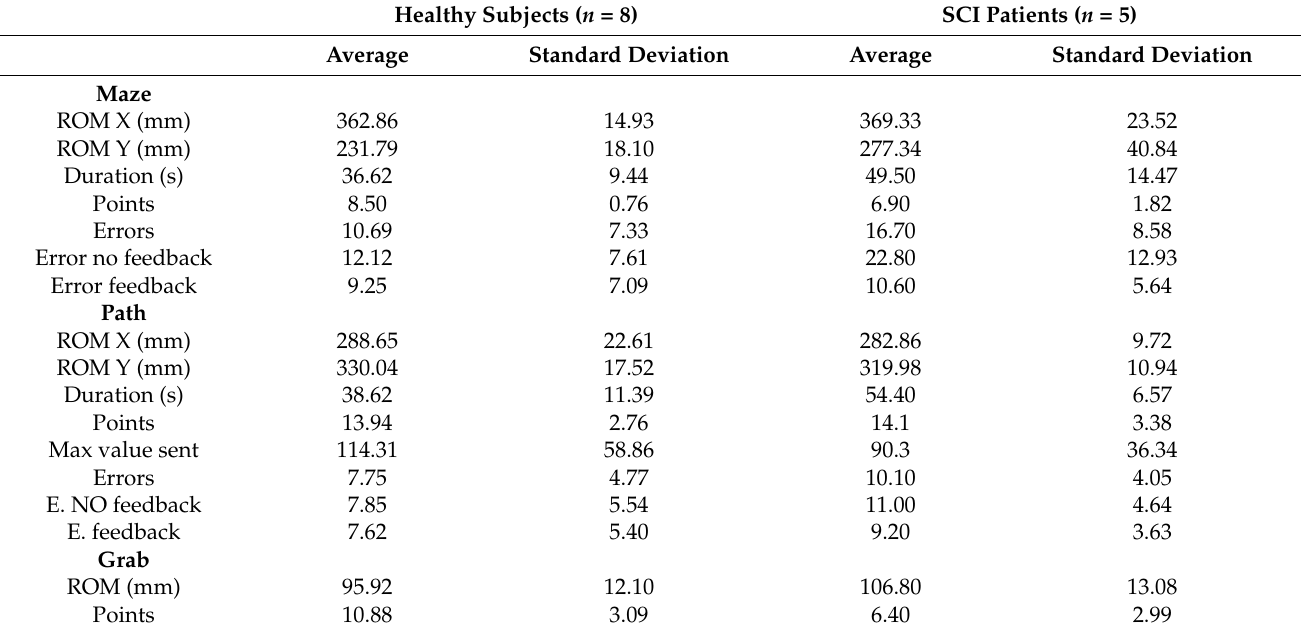
Table 3. Average and standard deviation results for the three games with healthy and SCI